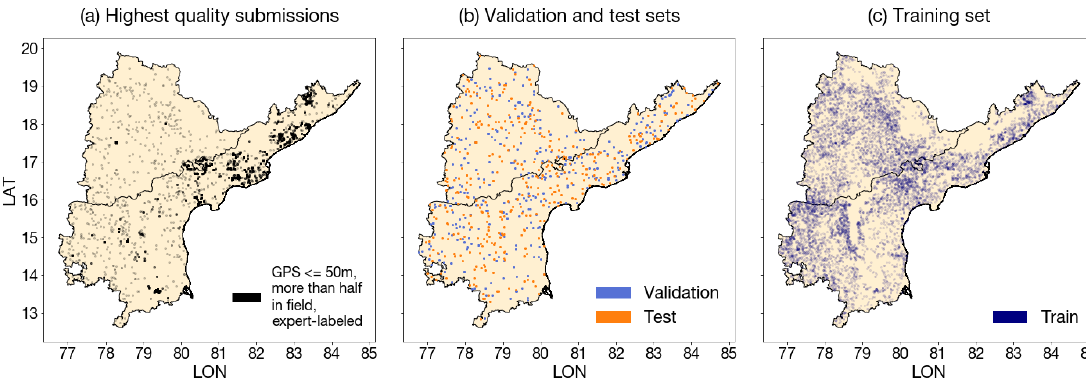
Figure A8. Maps of Plantix training, validation, and test sets for crop type classification. ( a ) To build the validation and test sets, we started with the highest quality submissions (GPS accuracy ≤ 50 m, more than half of the Sentinel-2 pixel is in a field, crop type was assigned by a human expert). These submissions were highly concentrated in the eastern half of Andhra Pradesh. ( b ) High quality submissions were re-sampled in a spatially uniform way to form the validation and test sets ( n = 400 for both). ( c ) The training set was filtered from the remaining dataset to be ≥ 500 m away from any points in the validation and test sets, with GPS accuracy ≤ 50 m and more than half of the Sentinel-2 pixel in a field.